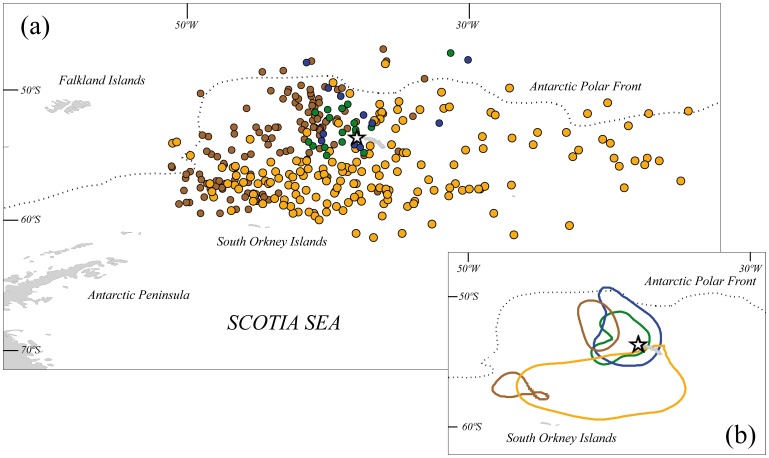
Spatial distribution of foraging areas.(a) Locations and (b) core areas (50% kernel contours) of 10 Antarctic prions (brown symbols & contours), 12 blue petrels (orange symbols & contours), 9 common diving petrels (blue symbols & contours) and 8 South Georgian diving petrels (green symbols & contours) tracked using geolocators during incubation at Bird Island, South Georgia in summer 2010/11. The white star indicates the position of the colony.